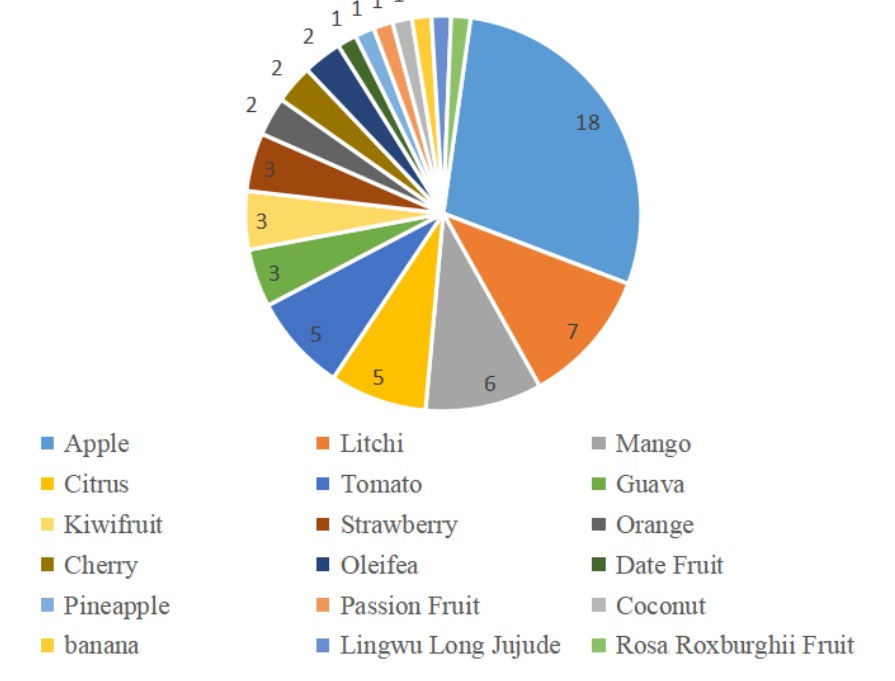
Figure 2. Species and quantity of fruit involved in the